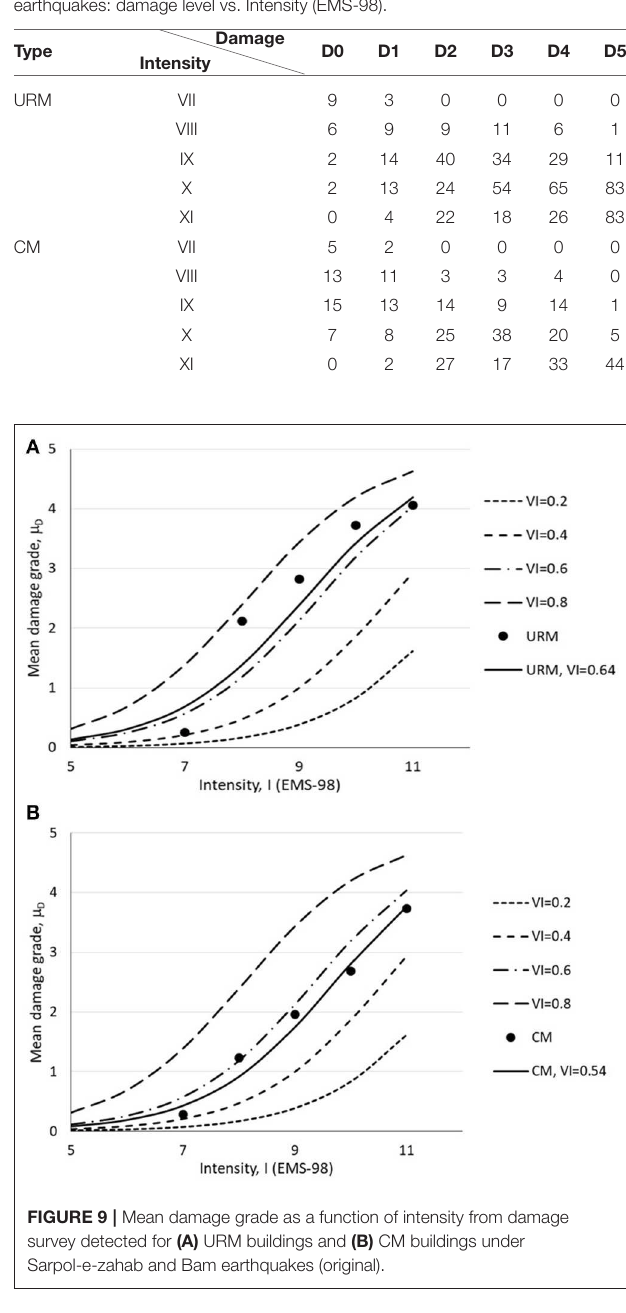
TABLE 3 | Damage probability matrix surveyed after Sarpol-e-zahab and Bam earthquakes: damage level vs. Intensity (EMS-98).